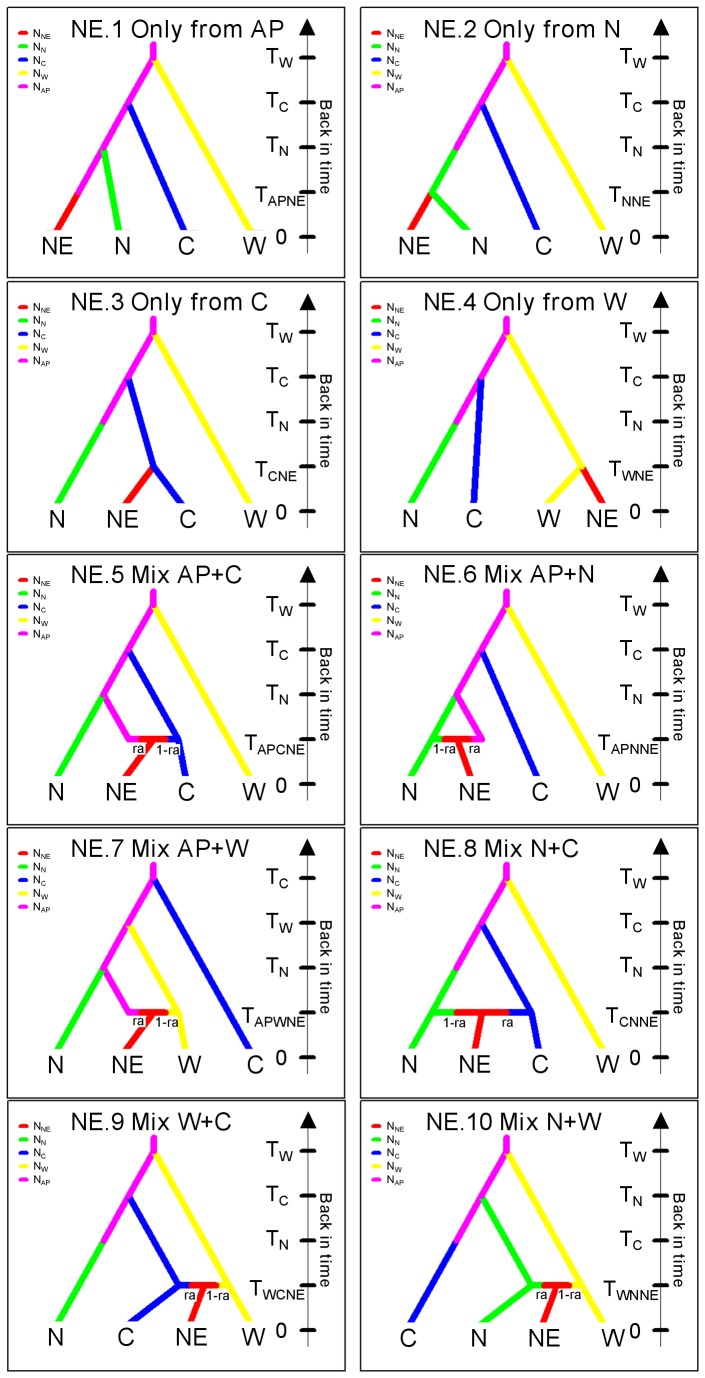
Schematic representations of ten competing scenarios designed to test the origin of the NE group by Approximate Bayesian Computation (ABC) analysis.Ni corresponds to effective population sizes of each group. The time of events (Ti), in numbers of generation, are not sorted by increasing times but are presented randomly as their prior distribution overlapped (Table 2). Several conditions were considered: TNNE<TN, TCNE<TC, TWNE<TW, TAPCNE<TC, TAPNNE<TN, TAPWNE<TW, TCNNE<TC and TN, TWCNE<TW and TC, TWNNE<TW and TN. Time 0 is the sampling date. Abbreviations are as follows: ancestral population (AP), western group (W), central group (C), northern group (N), northeastern group (NE), admixture rate (ra).